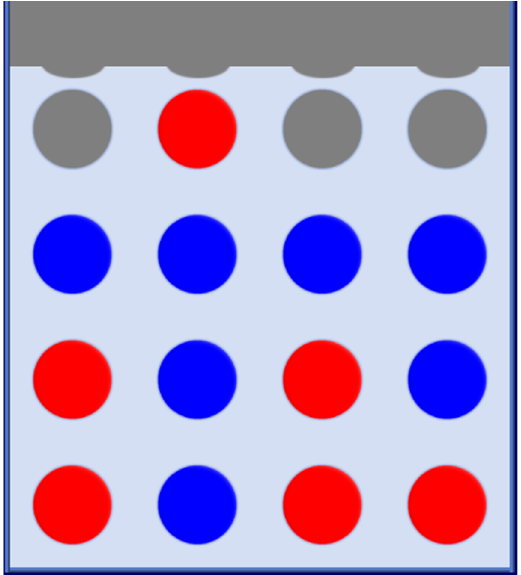
Figure 2. A finished game of Connect-4 on a 4 × 4 board, won by the blue player.